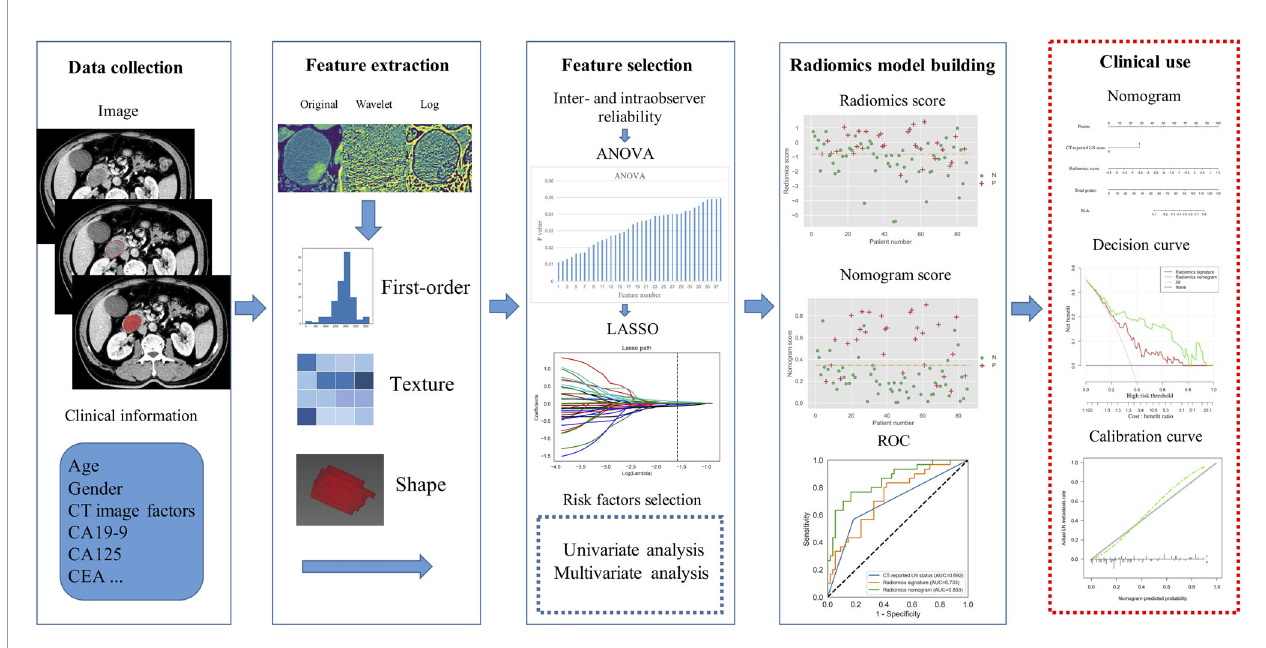
FIGURE 2 | Flow diagram of radiomics